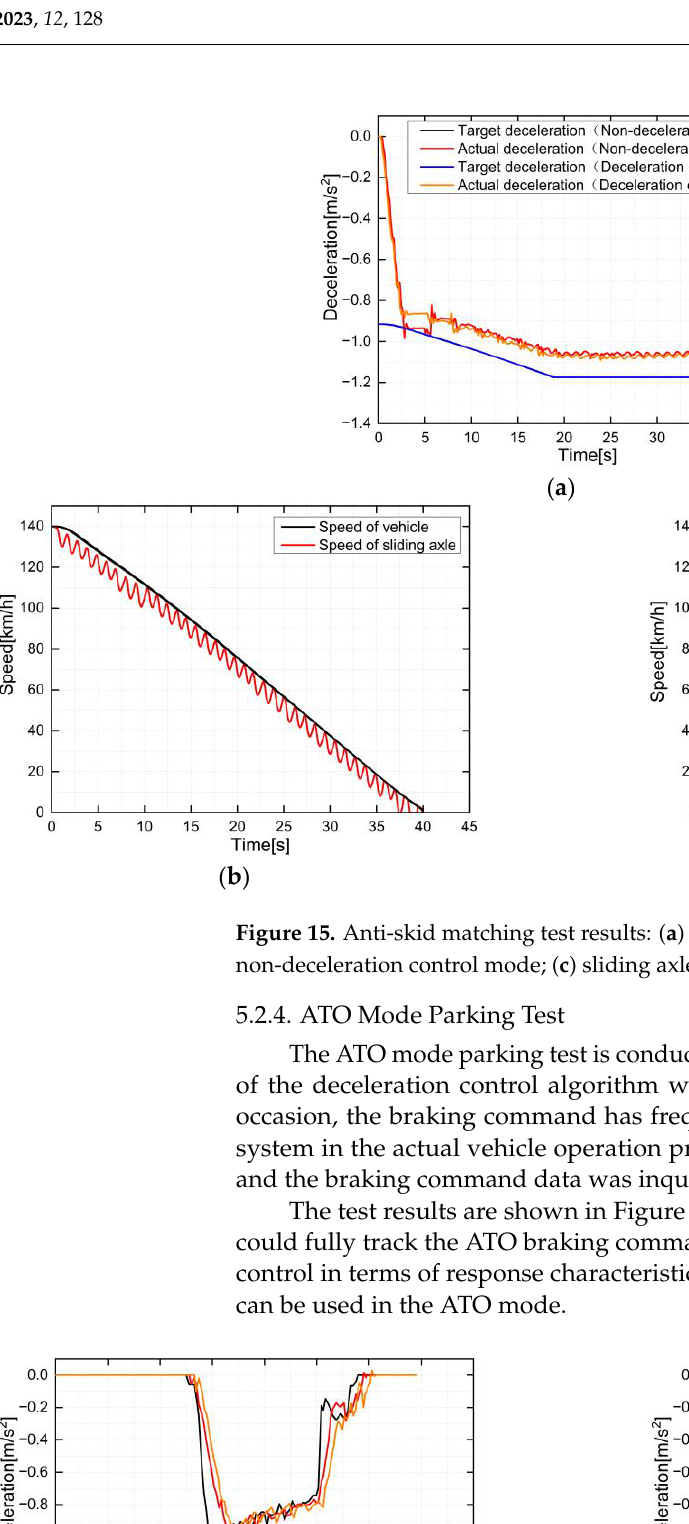
15 of 19 Table 3. Test results of each condition. Results